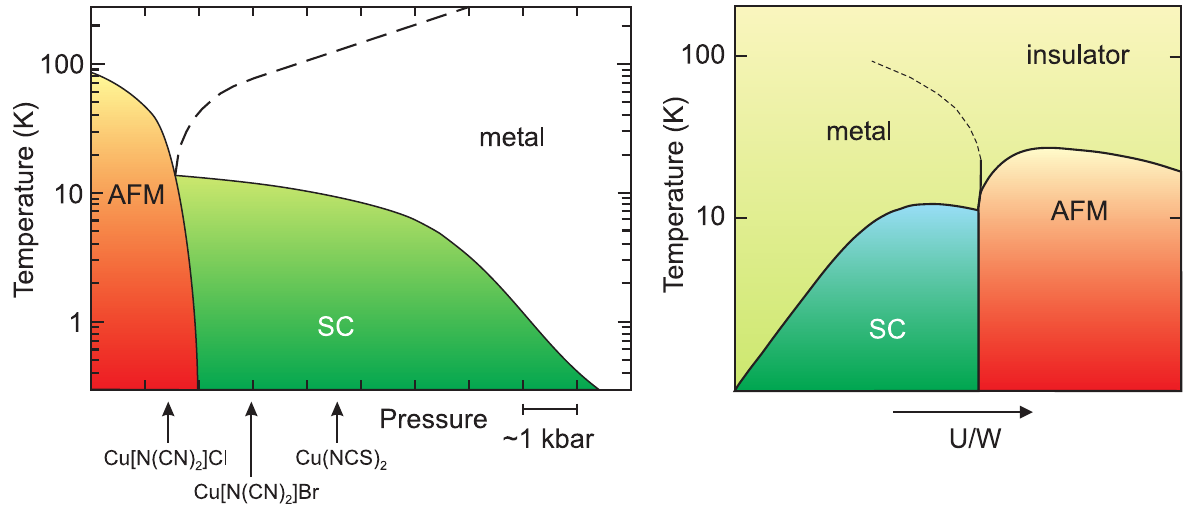
Figure 6. (left) Schematic P − T phase diagram for (cid:20) -(BEDT-TTF) regions of antiferromagnetic-insulator (AFM) behavior and superconductivity (SC). The arrows indicate starting points for different materials (the anion X is stated) at ambient pressure. The right conceptual phase diagram after [46] for (BEDT-TTF) the observed phases to a Mott transition. U is the on-site Coulomb repulsion and W denotes the electronic